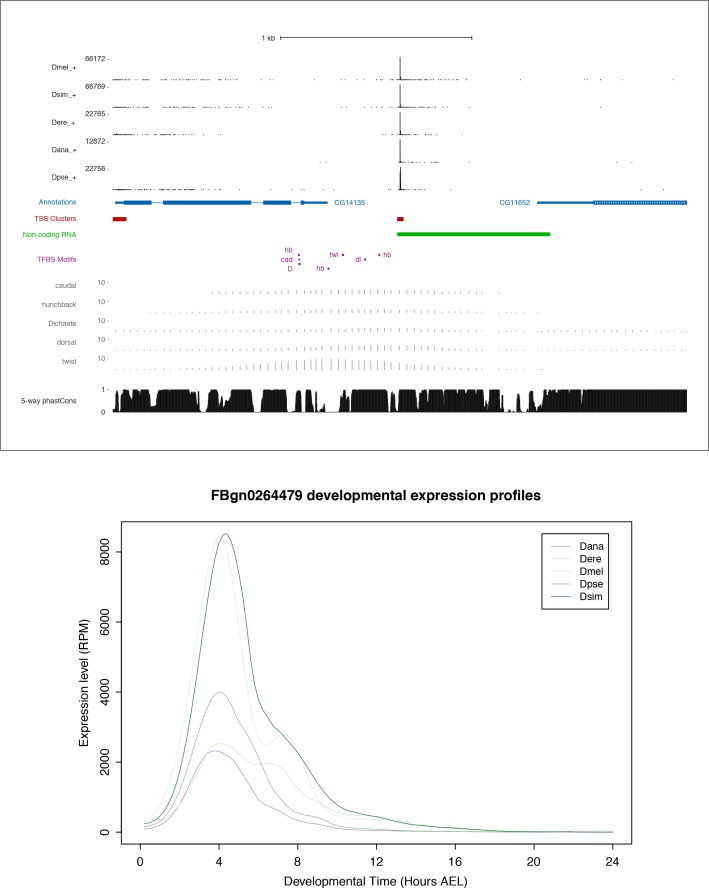
FBgn0264479 locus and expression.Top: FBgn0264479 locus organization. Includes all data tracks from Figure 6A. In addition, the five tracks just above the phastCons scores represent the chromatin immunoprecipitation microarray data (ChIP-chip) for five transcription factors: caudal, hunchback, Dichaete, dorsal, twist (modENCODE data visualized on the UCSC Genome Browser). Bottom: Expression profiles in reads per million (RPM).